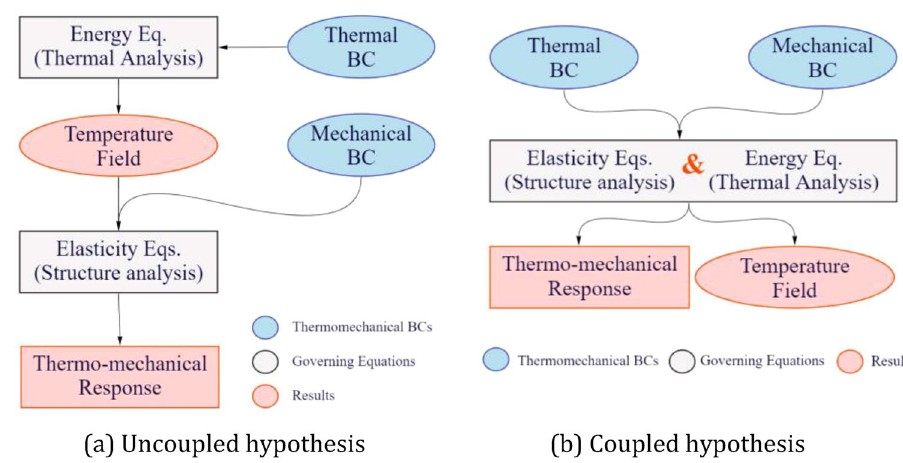
Fig. 1 Flow work solution of thermo-elasticity